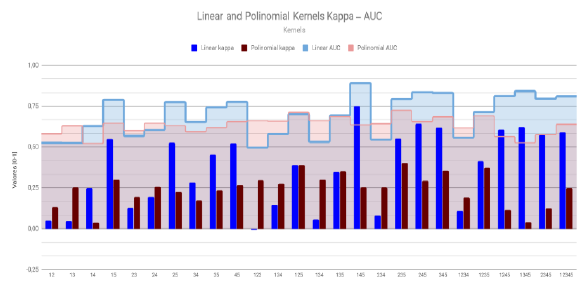
Figure 3 . Performance of SVM kernels per band combination .